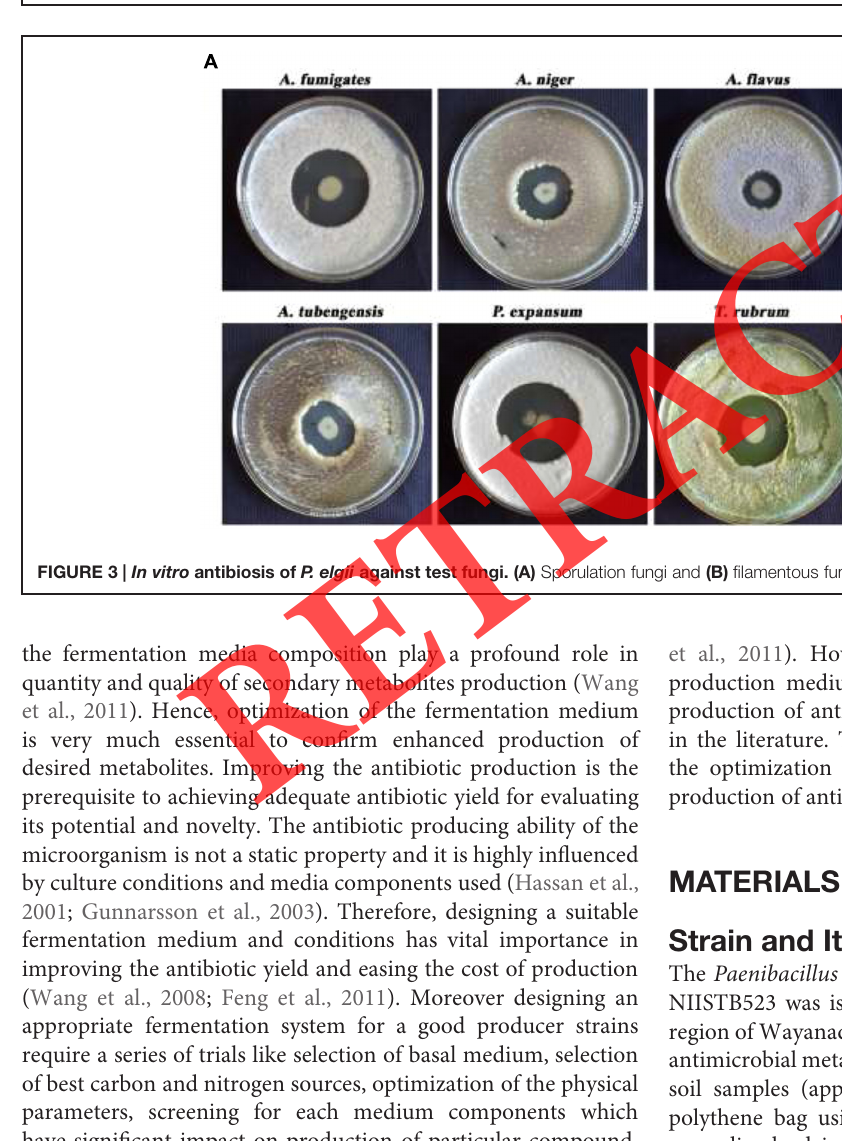
FIGURE 2 | In vitro antibiosis of P. elgii against test bacteria.